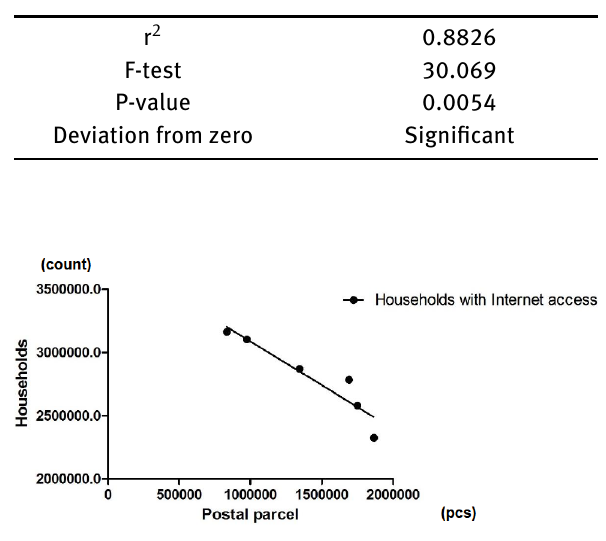
Figure 5: Dependence of postal parcel on households with Internet